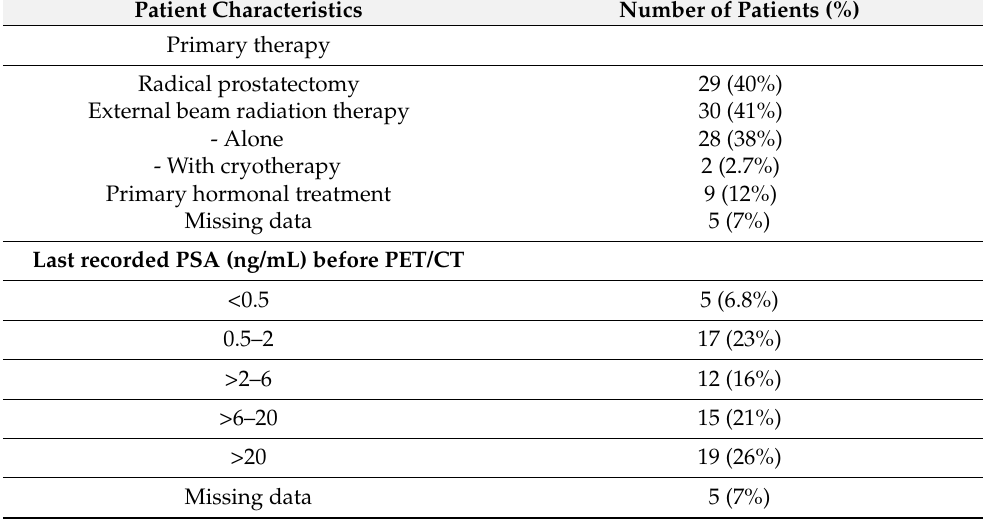
Table 1. Patient characteristics (n = 73) at the time of referral for 18F-fluciclovine PET/CT.